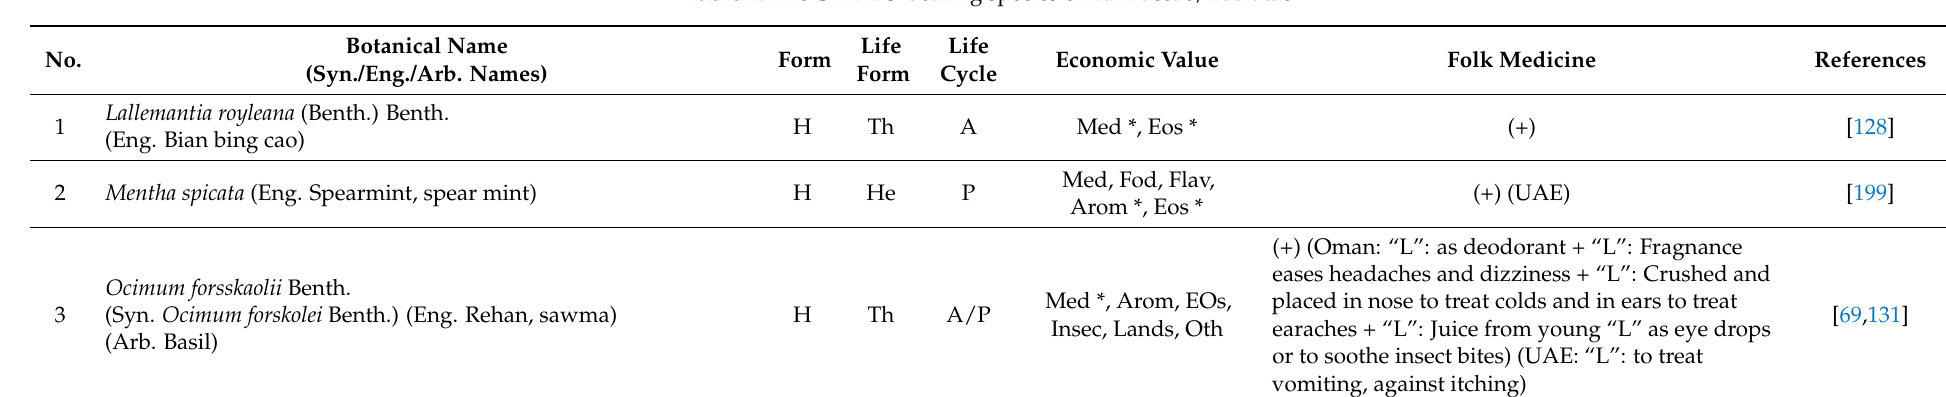
Table 4. The UAE EO-bearing species of